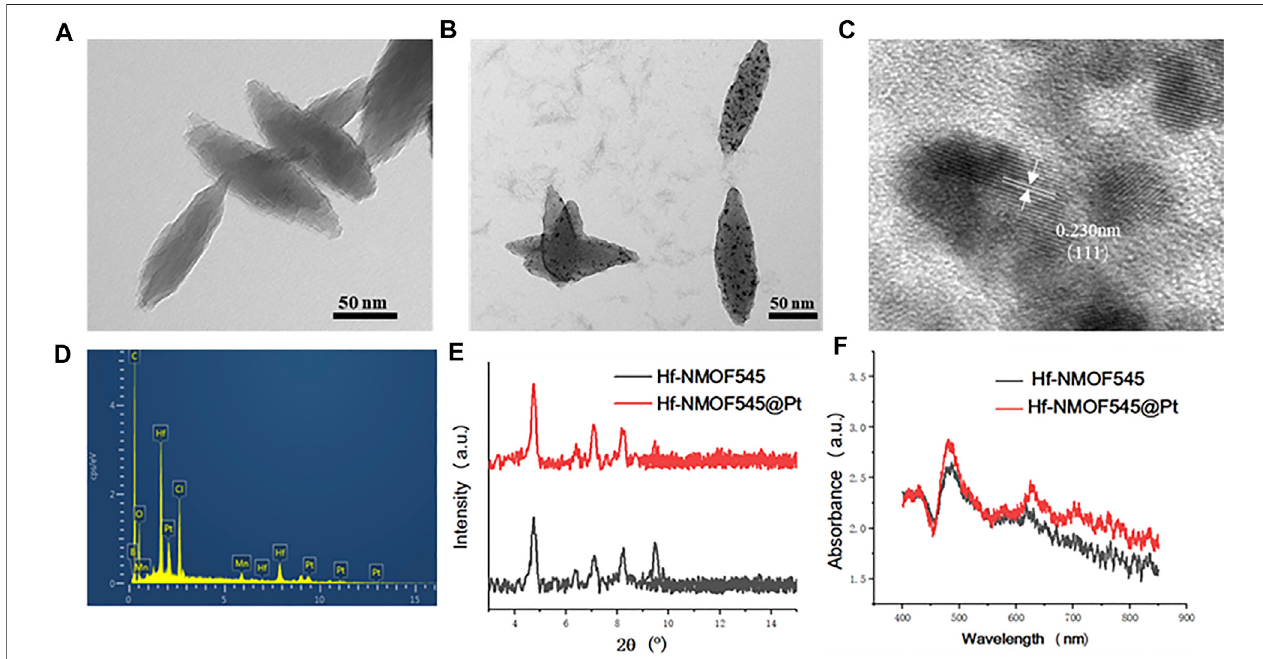
FIGURE1 | Characterization ofNMOF545 and NMOF545@Ptnanocomposites. (A) TEM image of NMOF545; (B) TEMimage ofNMOF545@Ptnanoparticles; (C) high-resolutionTEMimageofPtNPs; (D) EDSspectrumofNMOF545@Ptnanoparticles; (E) XRDpatternsoftheNMOF545andNMOF545@Pt; (F) UV-visabsorptionof NMOF545 and